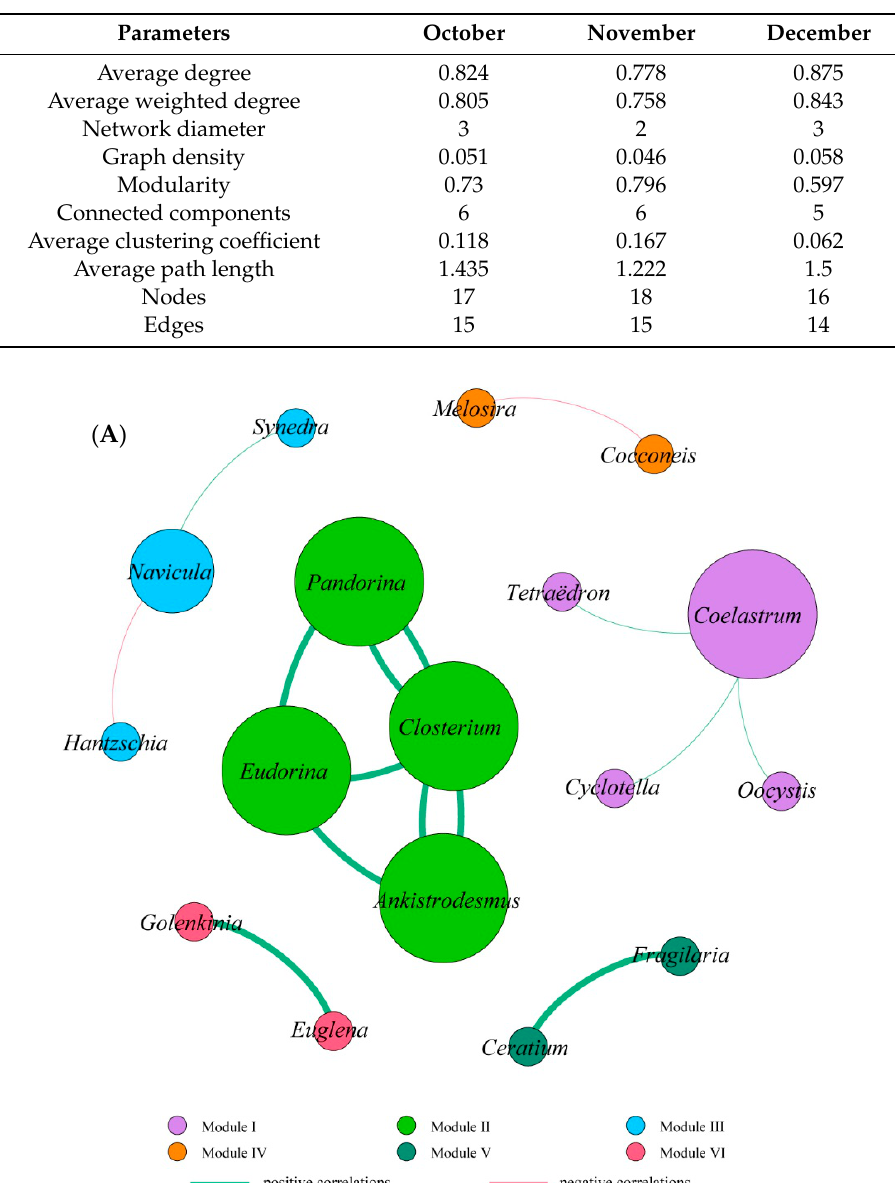
Table 2. Three individual network properties of phytoplankton communities at the genus level.